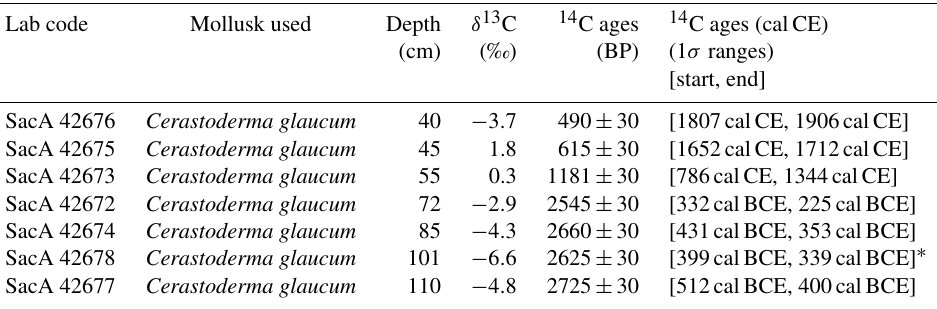
Table 2. 14 C data for shells from GEM4. The model ages were determined by OxCal. The 14 C ages are calculated and calibrated using the curve of Marine13 calibration with reservoir age.